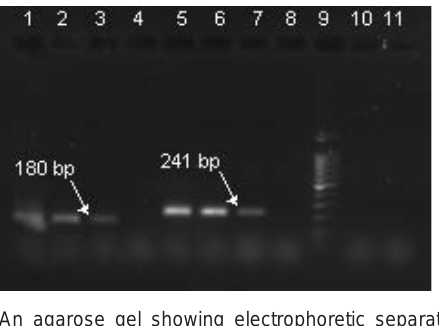
FIG. 4 An agarose gel showing electrophoretic separation of sdn-PCR products obtained from a five-fold dilution range of DNA extracted from whole blood of bovines infected with OvHV-2 (lanes 1–4) and AlHV-1 (lanes 5–8). [Lanes 1 and 5: 25 ng; lanes 2 and 6: 5 ng; lanes 3 and 7: 1 ng and lanes 4 and 8: 0.2 ng total DNA extracted from blood of the respective bovines.] Lanes 10 and 11 show nega- tive control samples in which water was used as PCR template; lane 9: contains a 100 bp DNA ladder